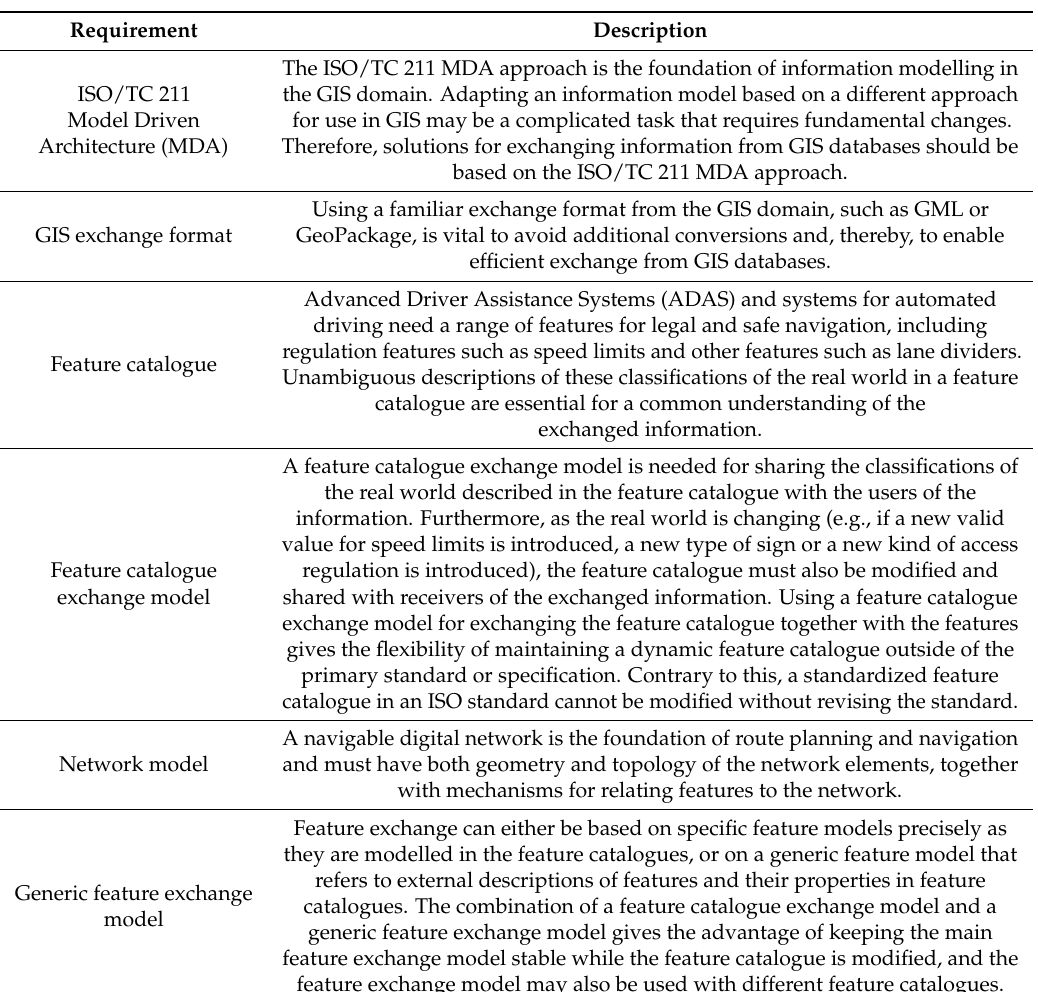
Table 2. Requirements used in the evaluation of